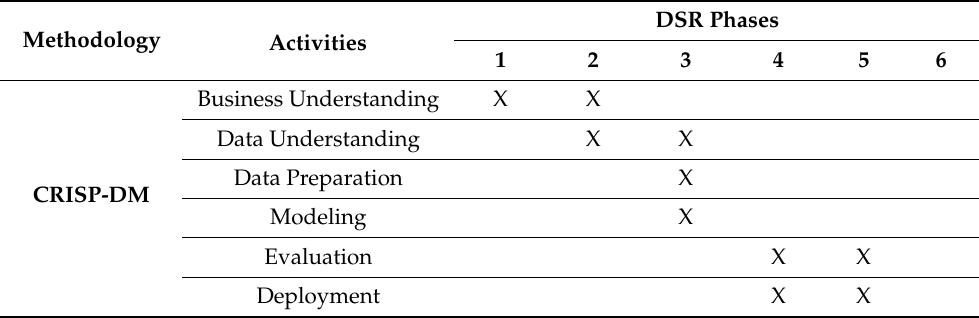
Table 2. Crossover of CRISP-DM and DSR methodologies.